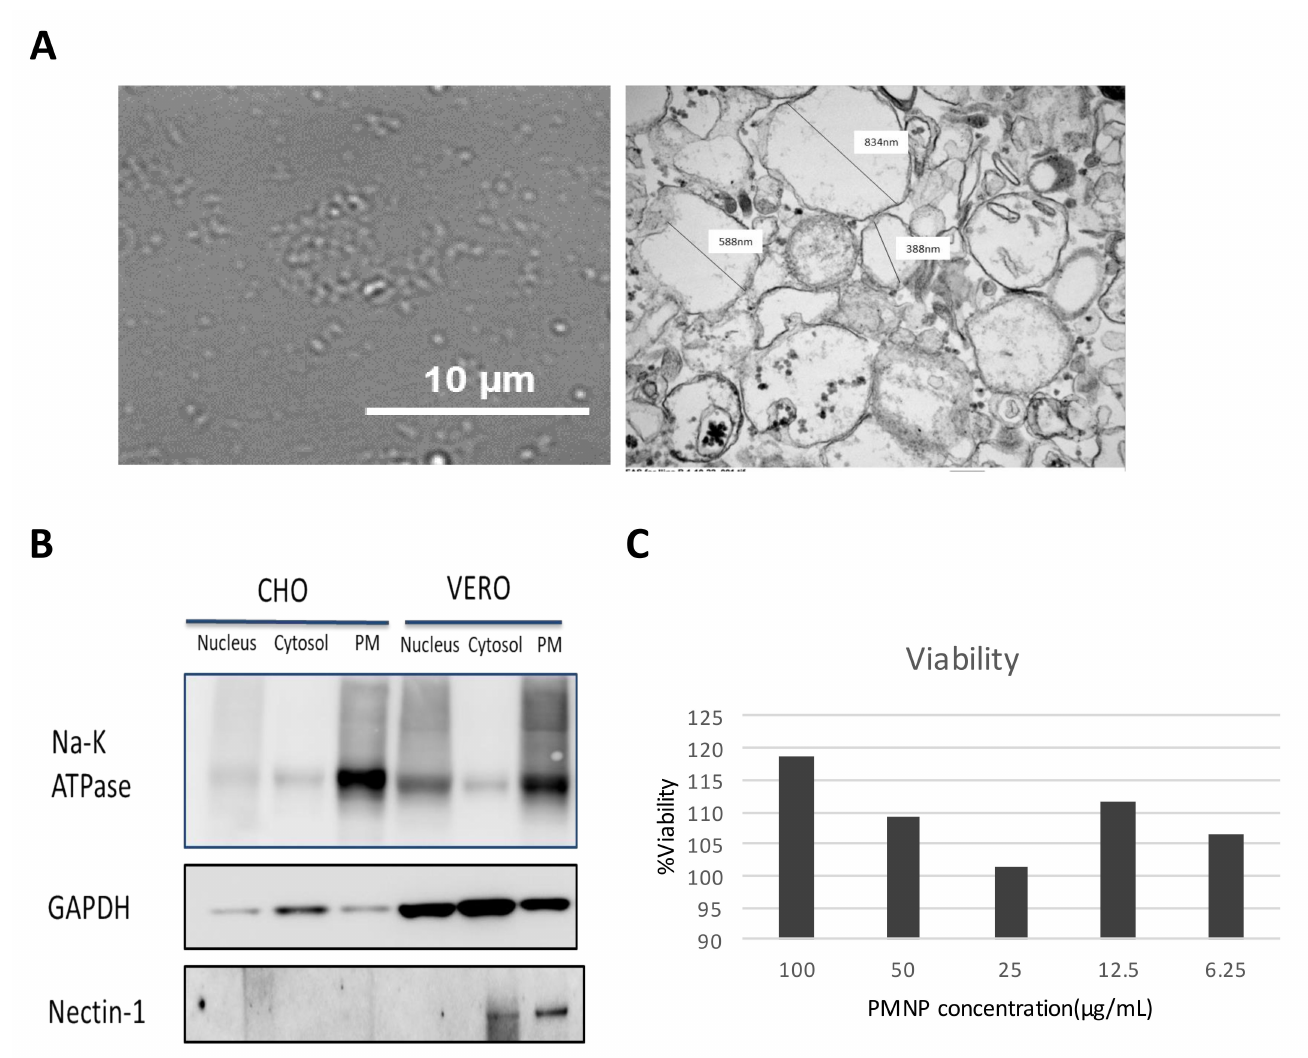
Figure 2. Characterization and validation of the plasma membrane fraction isolated by a column- based kit: ( A ) A 100 × image of isolated plasma membrane NPs isolated from Vero cells taken on the brightfield channel of a light microscope. (right) TEM images of plasma membrane particles isolated from Vero cells. ( B ) Western blotting analysis of the various fractions isolated from the whole cell lysate. ( C ) Cell viability of plasma membrane-treated HCE cells assessed by MTT